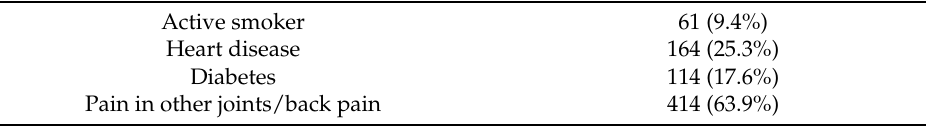
Table 2. Patients’ exposures n (%).